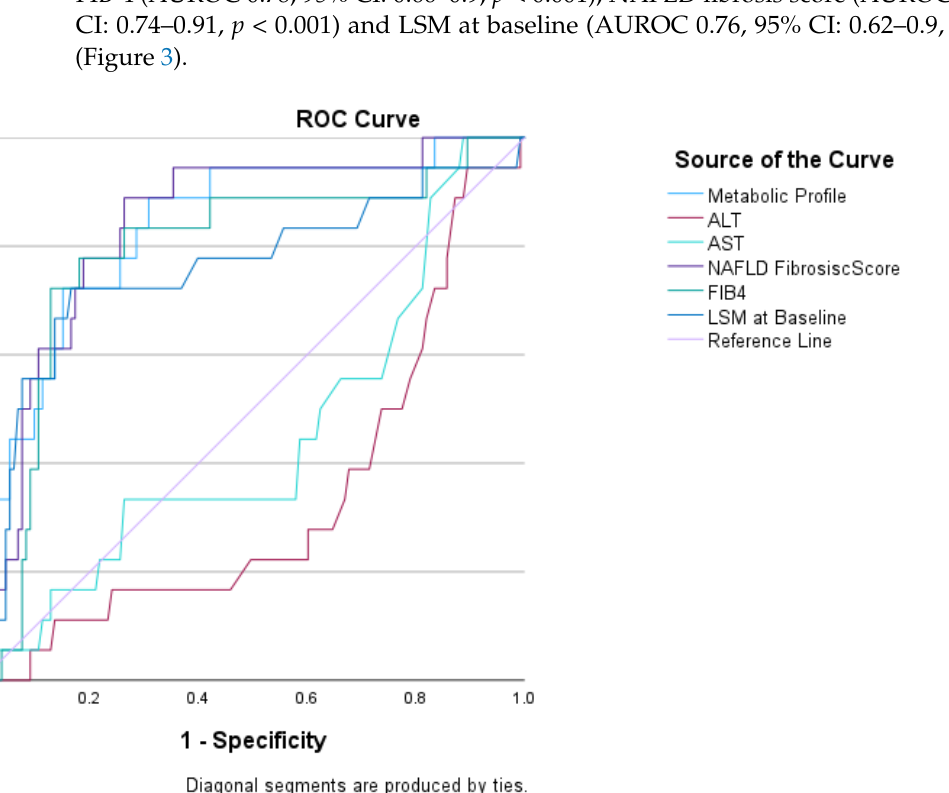
Figure 3. Diagnostic performance of a combination of metabolites to predict the presence of cirrhosis. Abbreviations: ALT, alanine aminotransferase; AST, aspartate aminotransferase.